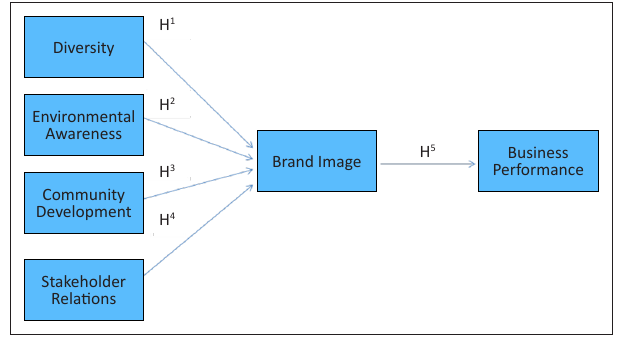
FIGURE 1: Hypothetical model.